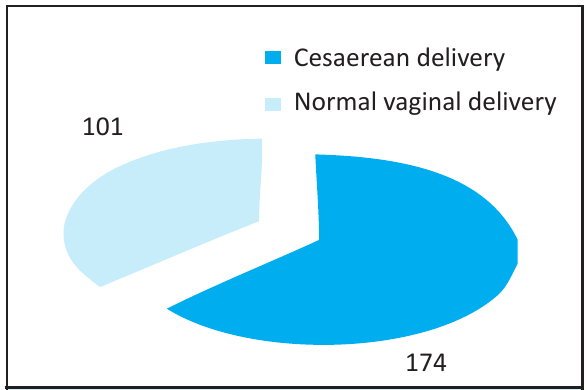
Figure 1. Percentage of vaginal and cesarean delivery.